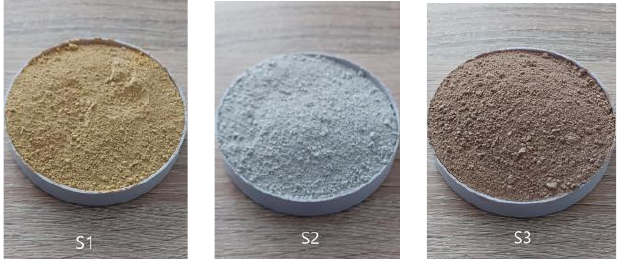
Figure 1. Clay samples in powder form: S1 — clay raw material from a deposit in Germany, S2 — clay raw material from a deposit in Estonia, S3 — clay raw material from a deposit in Lithuania.